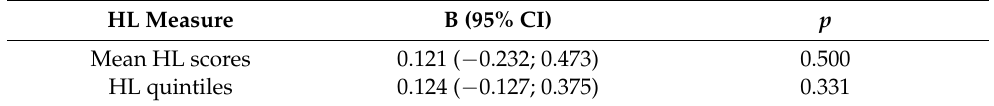
Table 2. Relationship between children’s HL and BMI